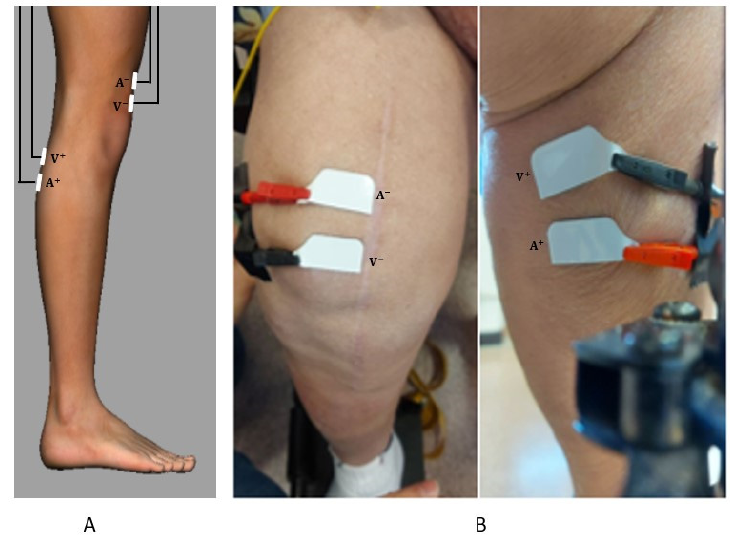
Figure 5. ( A ): Sagittal view of the leg model with electrode placement ( B ): actual electrode placement on the patient.